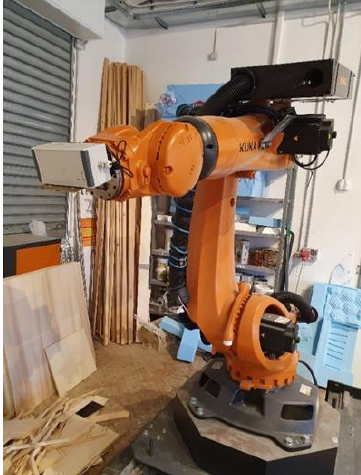
Figure 6. Test setup for system output stability.